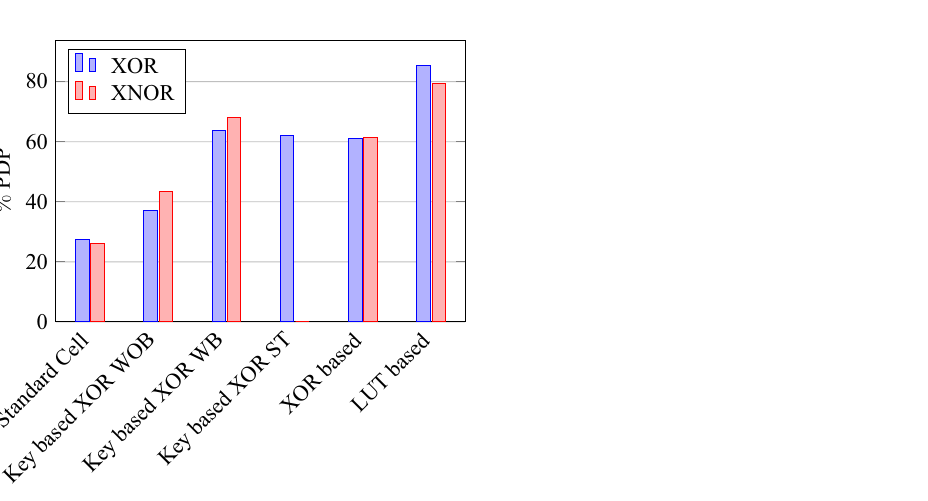
Figure 46. % of Change in PDP for XOR & XNOR gates compared to proposed design.